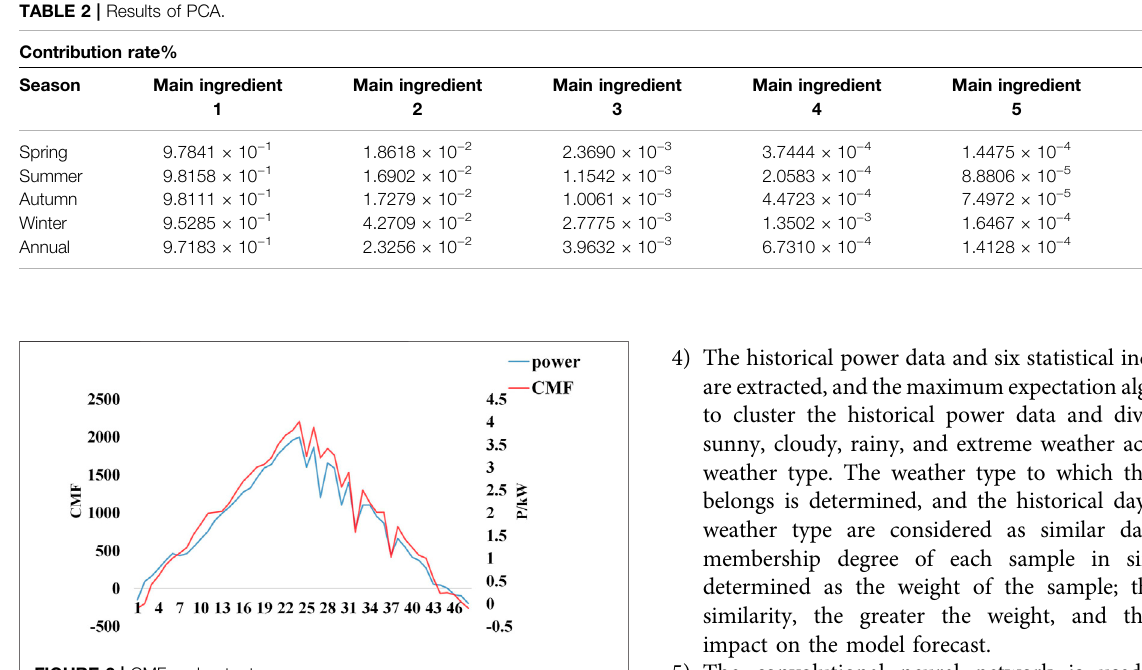
FIGURE 2 | CMF and output